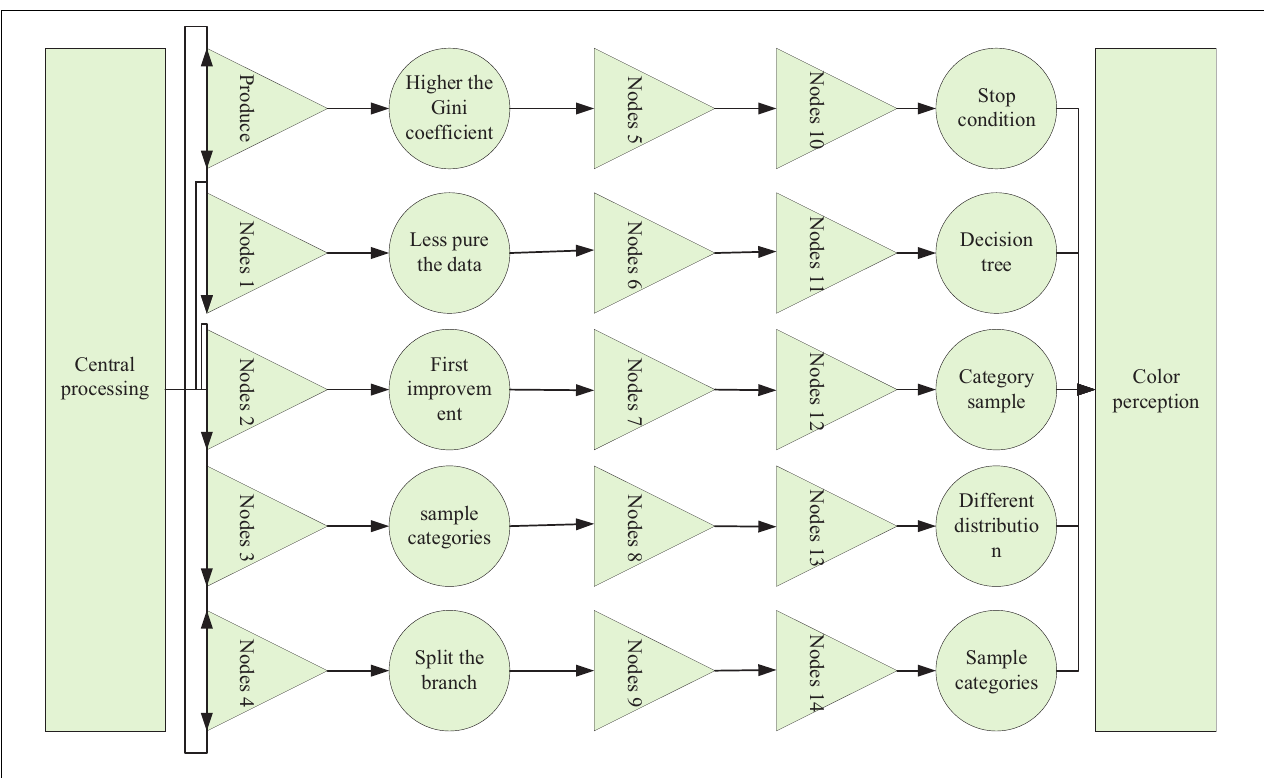
FIGURE 2 | Schematic of the color vision mechanism.